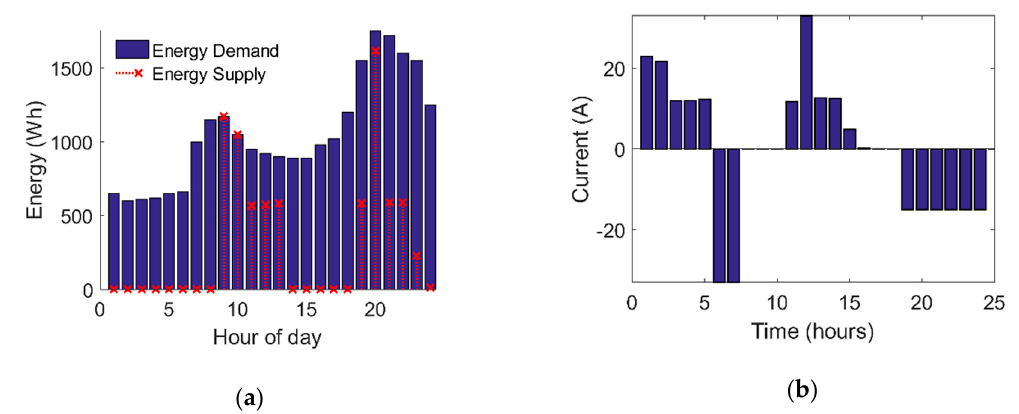
Figure 16. BESS operation schedule: ( a ) Energy distribution; ( b ) Charging and discharging currents.